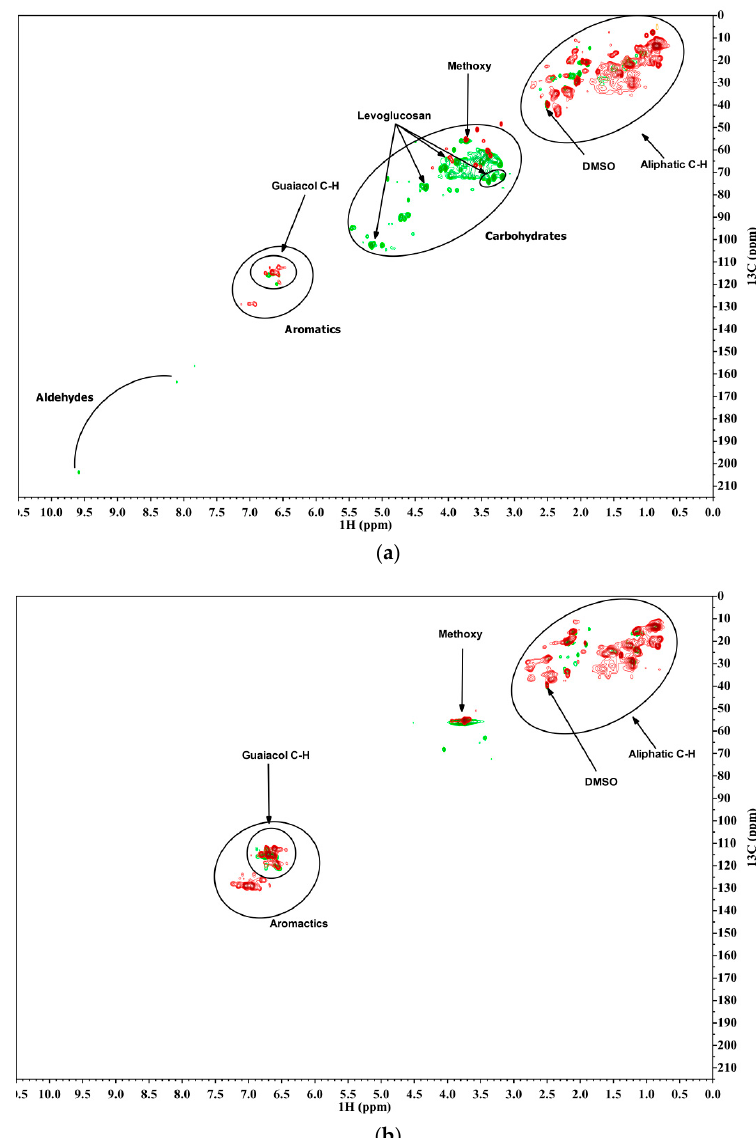
Figure 5. Heteronuclear Single Quantum Coherence (HSQC) spectra of PS, PL and their product oils after catalytic hydrotreatment over Ni-Mo/SiO 2 -Al 2 O 3 at 350 °C in 4 h: ( a ) PS (green) and hydrogenated oil product (red), ( b ) PL (green) and hydrogenated oil product (red). The NMR data for PS show the presence of anhydrosugars (e.g., levoglucosan) and carbonyl compounds, as well as some aromatic structures. The latter are likely due to incomplete separation of the PL. For the PL feed, the expected aromatic C-H bonds (i.e., guaiacyl structure) and methoxy groups were observed. After catalytic hydrotreatment of PS, the intensity of aliphatic C-H groups considerably increases at the expense of anhydrosugars and carbonyls. For the PL fraction, a strong reduction in the methoxy group intensities is observed, whereas the intensity and the position of certain peaks in the aliphatic C-H domain changes. These results indicate that PS indeed is very reactive, and is fully converted at 350 °C in 4 h, while the PL is less reactive.